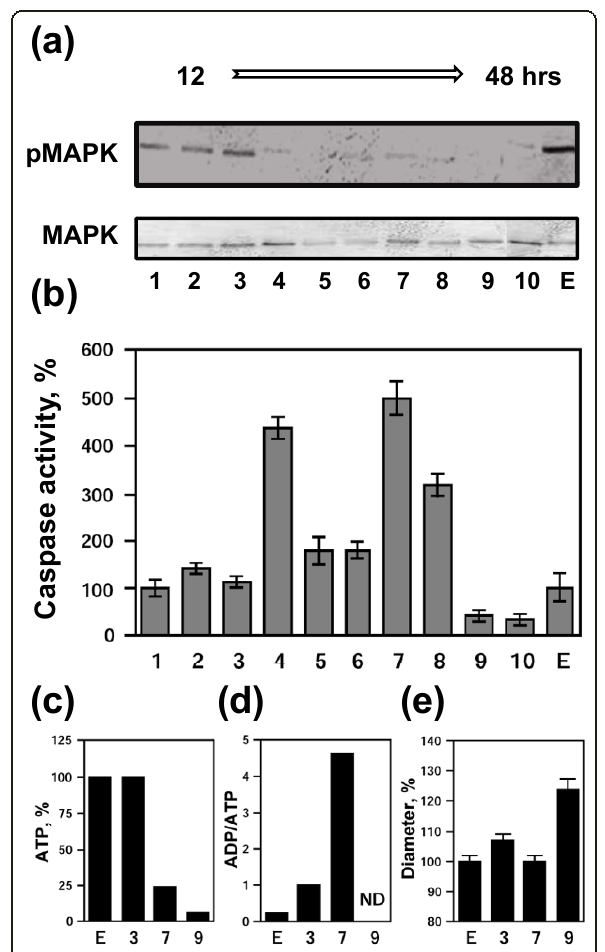
Figure 4 Single-cell analysis of unfertilized Xenopus eggs . MAPK phosphorylation state (a) and caspase 3 activity (b) were determined in the single unfertilized eggs #1-10 taken at different times (12 - 48 hours) after their deposition into OR-2 buffer. Eggs #1-3 were collected within 12 hours of ovulation, eggs #4-8 - within 18-36 hours, and eggs #9-10 - at 48 hours after ovulation. The control egg E was withdrawn immediately after its deposition. Relative intracellular ATP content (c) , ADP/ATP ratio (d) , and egg diameter (e) were determined for the eggs #3, 4, 9, and E. Bars in (b) and (e) represent the range of duplicate measurements. The total number of eggs taken for the single-cell analysis was 39, among them, 10 eggs were collected within 12 hours of ovulation, 22 eggs - within 18-36 hours, and 7 eggs - at 48 hours after